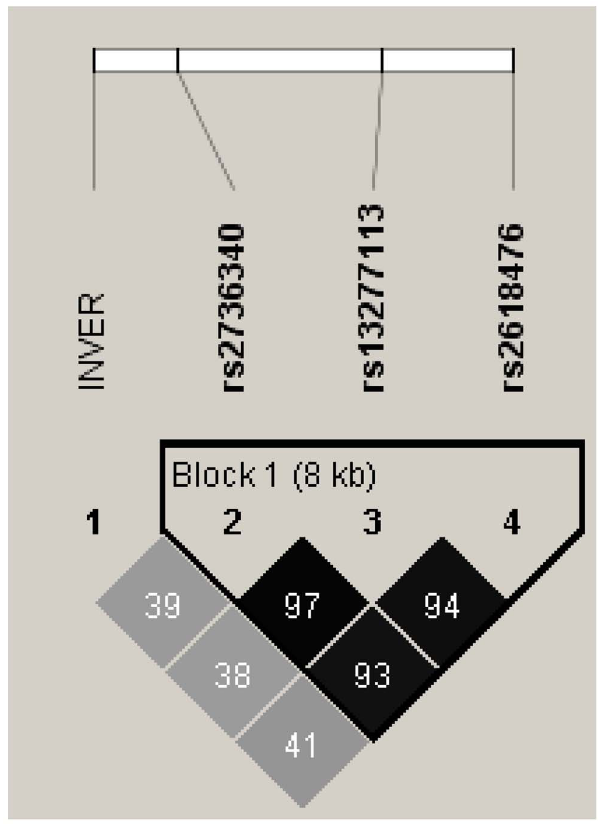
Fig. 4. A schematic representation of haplotype block of 3 published lupus related snps at or near BLK and their degree of LD (r2) with inversion status (rs2736340, rs13277113, rs2618476). INVER 5 putative inversion